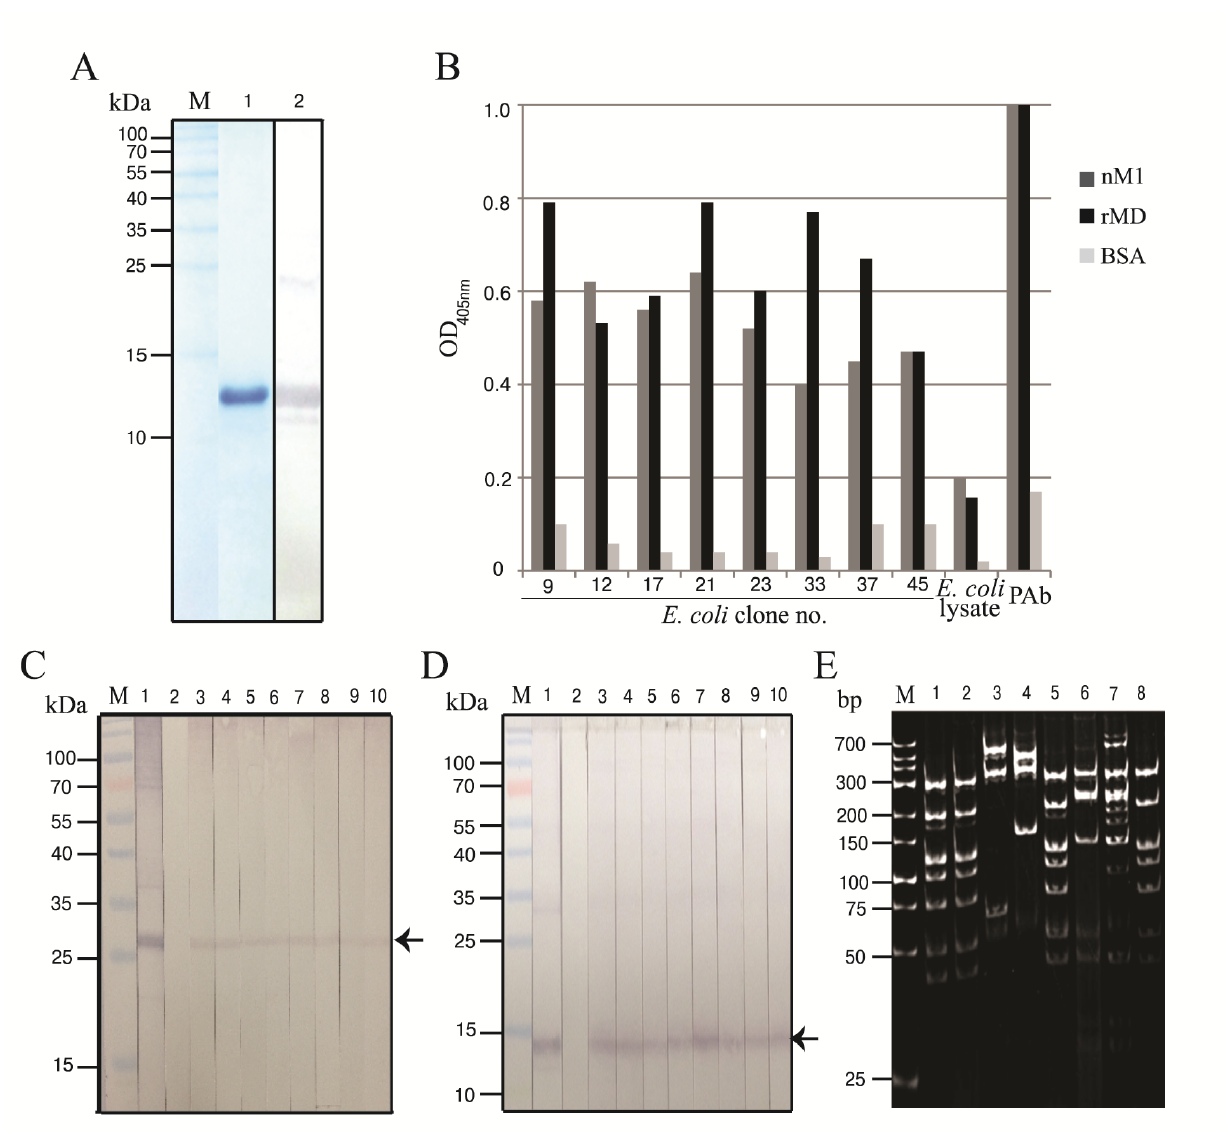
Figure 1. Recombinant M1 middle domain (rMD) and characterization of the selected phagemid transformed-HB2151 E. coli clones. ( A ) Recombinant MD. Lane M, protein molecular mass marker; lane 1, SDS-PAGE separated-rMD stained with Coomassie™ Brilliant Blue G-250 dye; lane 2, Western blot pattern of the purified rMD revealed by mouse monoclonal anti-6× histidine tag, goat anti-mouse immunoglobulin-alkaline phosphatase and BCIP/NBT substrate; ( B ) Human scFvs from eight phagemid transformed HB2151 E. coli clones (nos. 9, 12, 17, 21, 23, 33, 37 and 45) showed higher ELISA signals to native M1 and rMD than to the BSA (control antigen). Mouse polyclonal antibody to rM1 (PAb) and normal E. coli lysate were used as a positive and negative antibody controls, respectively; ( C , D ) Western blot results for determining the binding of the scFvs of the eight clones to nM1 and rMD, respectively (lanes 3–10). Lanes M, protein molecular mass marker; lanes 1 and 2, PAb to rM1 and E. coli lysate which served as positive and negative antibody controls, respectively; ( E ) DNA banding patterns (RFLP) of the huscfv sequences of the eight transformed HB2151 E. coli clones after Mva I digestion, 12% acrylamide gel electrophoresis and ethidium bromide staining. Lane M, low molecular weight DNA